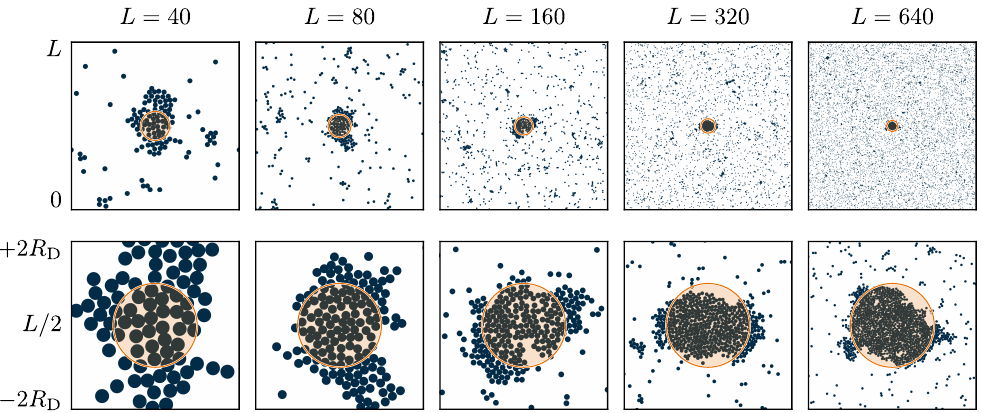
Figure 12: Example configurations at fixed temperature T = 0.4 for increasing sys- tem sizes. The snapshots were taken so that ρ and N attain their size-dependent D transition values, obtained via N (cid:48) (i.e. matching the blue crosses in Fig. 11, not the D analytic prediction). Although the droplet grows continuously with system size, its relative volume vanishes as the probability gas peak sharpens ( top row ). With in- creasing system size, the observed droplet volume and shape approach the analytic = ( a /πρ ) 1 / 2 L 2 / 3 , shown as shaded circle ( bottom row , prediction with radius R N D D l rescaled to R D